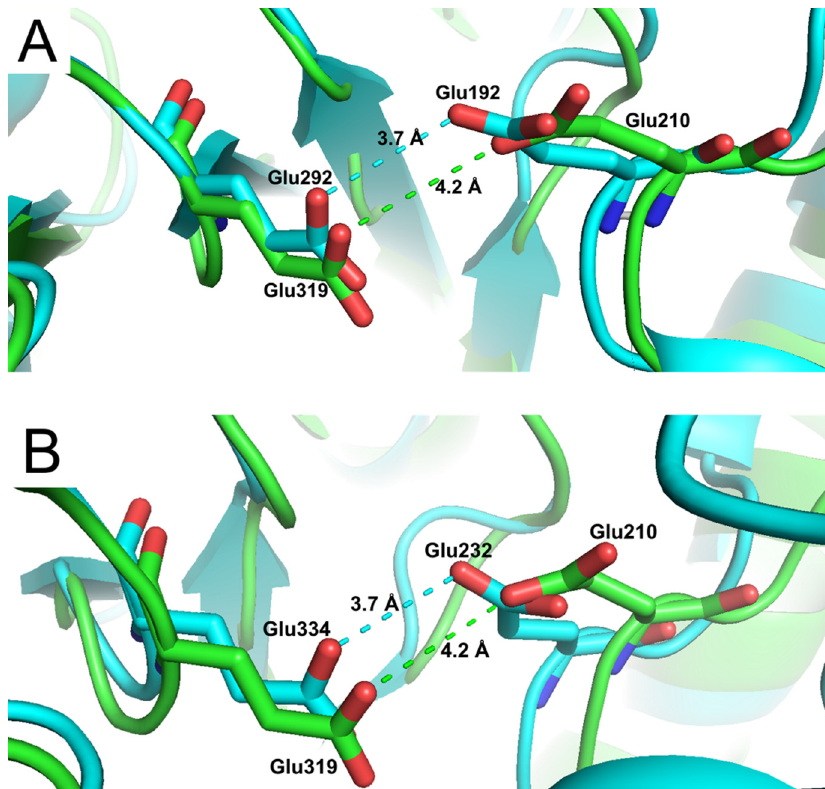
Figure 4. Overlay of the AnRut catalytic active site (green) with ( A ) exo ‐β‐ (1,3) ‐ glucanase (blue) from Candida albicans ( Ca Exg) or with ( B ) exo ‐β‐ (1,3) ‐ glucanase (blue) from Saccharomyces cerevisiae ( Sc Exg). Distances between active site residues Glu210 and Glu319 of AnRut (3.7 Å) and the corresponding residues ( A ) Glu192 and Glu292 (4.2 Å) in Ca Exg and ( B ) Glu232 and Glu334 (4.2 Å) in Sc Exg are displayed. Despite the low sequence identity of ca 20%, a high structural similarity between An Rut and both exo ‐β‐ (1,3) ‐ glucanases was found in their catalytic sites. The comparison of the An Rut surface area (colored according to hydrophobicity) with